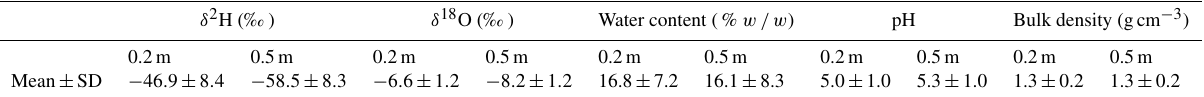
Table 2. Mean and standard deviation (SD) for isotopic signatures and soil physical properties at 0.2m and 0.5m soil depth ( N = 52 per depth).